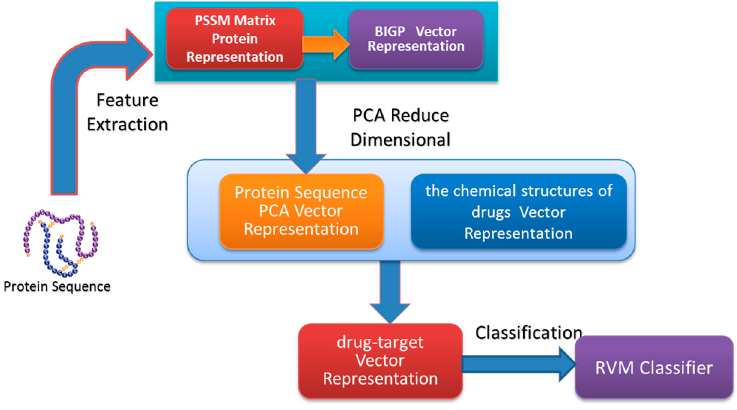
Figure 1. The flow chart of the proposed prediction model.